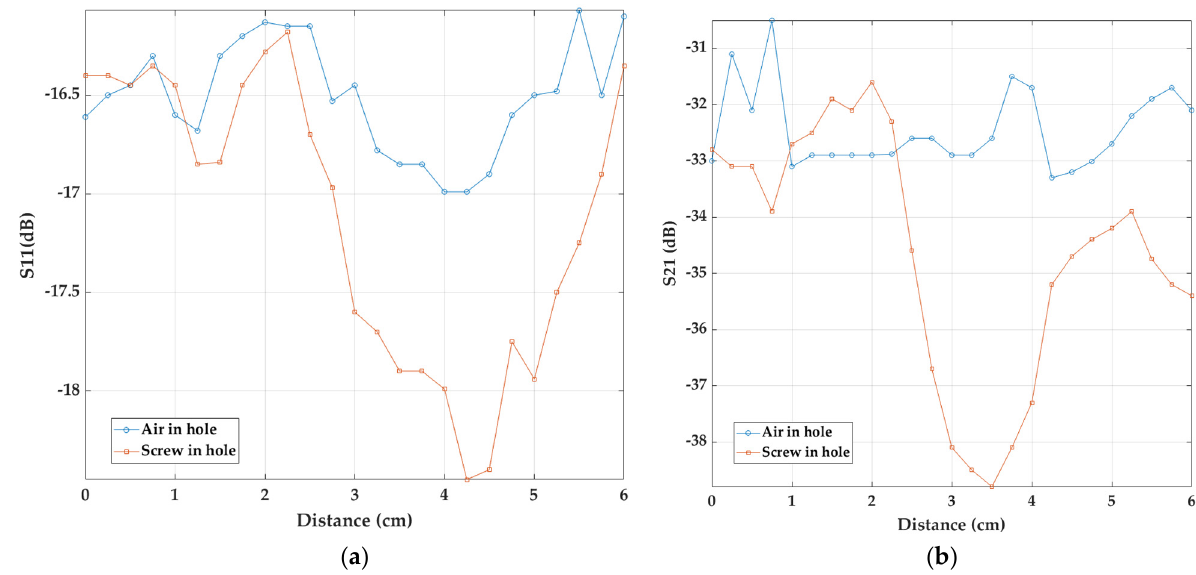
Figure 10. S 11 and S 21 measurements over the hole at 30 mm from the measurement surface at a distance of 3.5 cm: ( a ) reflection measurements for air-filled hole vs. bolt; ( b ) transmission measurements for the air-filled hole vs. the bolt. (b) Wood Beam, Hole 10 mm from the Measurement Surface